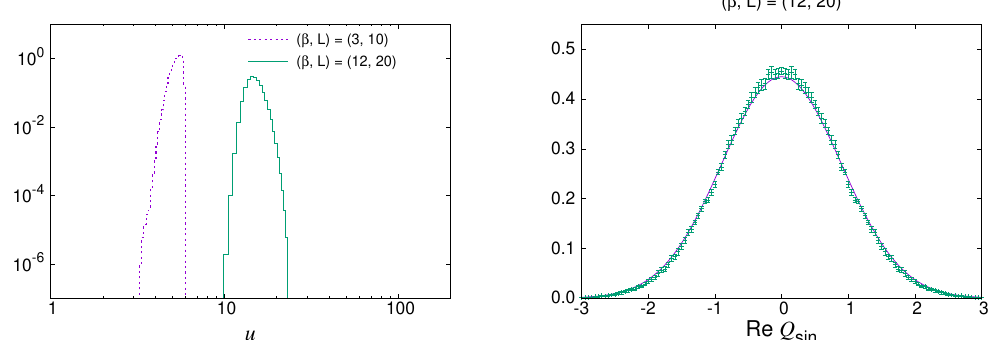
Figure 17 . The results obtained by the CLM for the punctured model using the sine de(cid:12)nition of the topological charge. (Left) The histogram of the magnitude u of the drift term is shown for ( (cid:12); L ) = (3 ; 10) and (12 ; 20) with (cid:18) = (cid:25) . (Right) The histogram of Re Q sin for the punctured model is shown for ( (cid:12); L ) = (12 ; 20) with (cid:18) = (cid:25) . The exact result obtained for ( (cid:12); L ) = (12 ; 20) with (cid:18) = 0 is shown by the solid line for